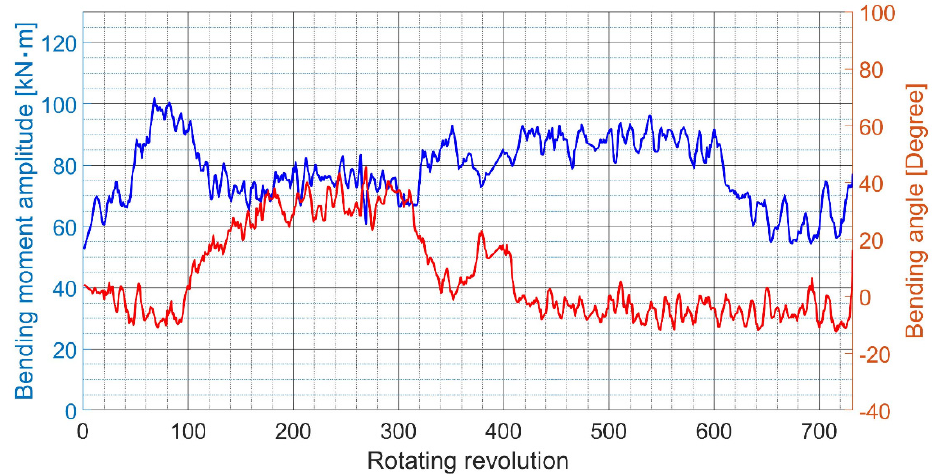
Figure 19. Bending moment during the port turn under the normal ballast condition.